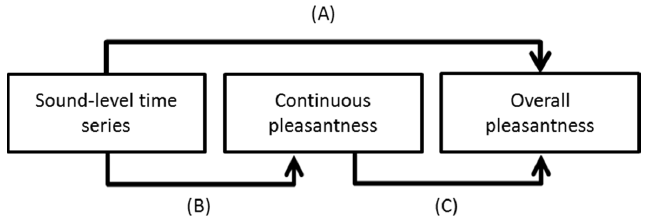
Figure 1. Modeling framework. ( A ): relations between sound ‐ level time series and perceived overall pleasantness; ( B ) relations between sound-level time series and perceived continuous pleasantness; pleasantness; ( B ) relations between sound ‐ level time series and perceived continuous pleasantness; ( C ): relations between perceived continuous and overall pleasantness ( C ( C ): relations between perceived continuous and overall pleasantness ( C ).